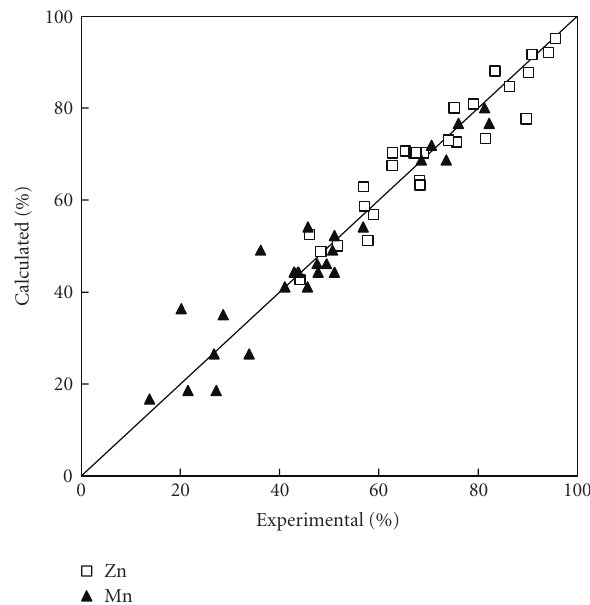
Figure 5: Scatter diagram of the experimental extraction yields at 5h versus those calculated by (7).